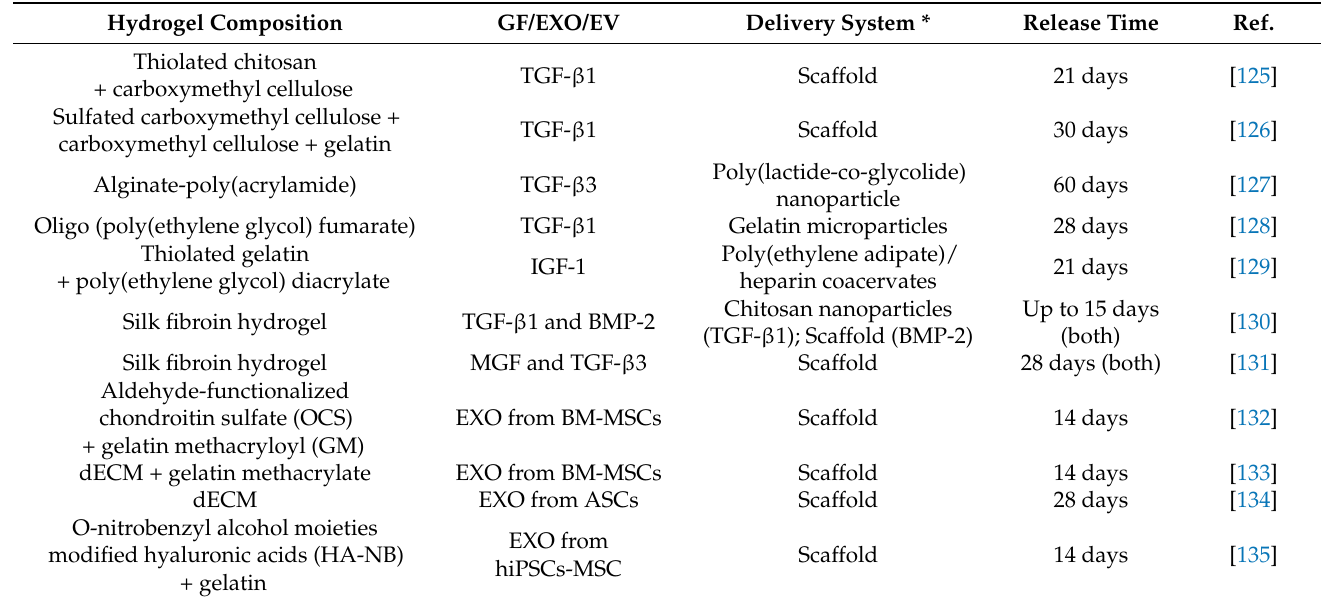
Table 1. Delivery systems and in vitro release time of growth factors and extracellular vesicles associated with hydrogels with different